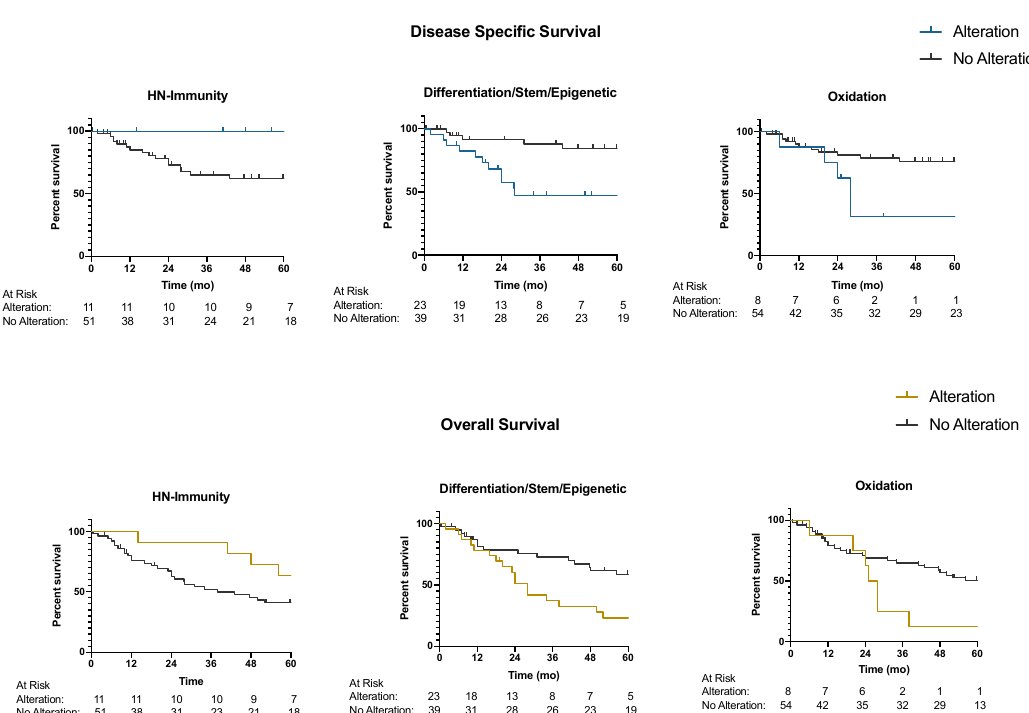
Figure 3. Five-Year disease specific and overall survival by pathway mutation. Kaplan-Meier survival curves for disease specific survival (DSS) and overall survival (OS) are depicted stratifying by mutations in the HN-Immunity pathway ( left ), Differentiation/Stem/Epigenetic pathway ( middle ), and Oxidation pathway ( right ). Mutations in the HN-Immunity pathway predict improved DSS and OS, while mutations in the Differentiation/Stem/Epigenetic and Oxidation pathways predict worse DSS and OS.